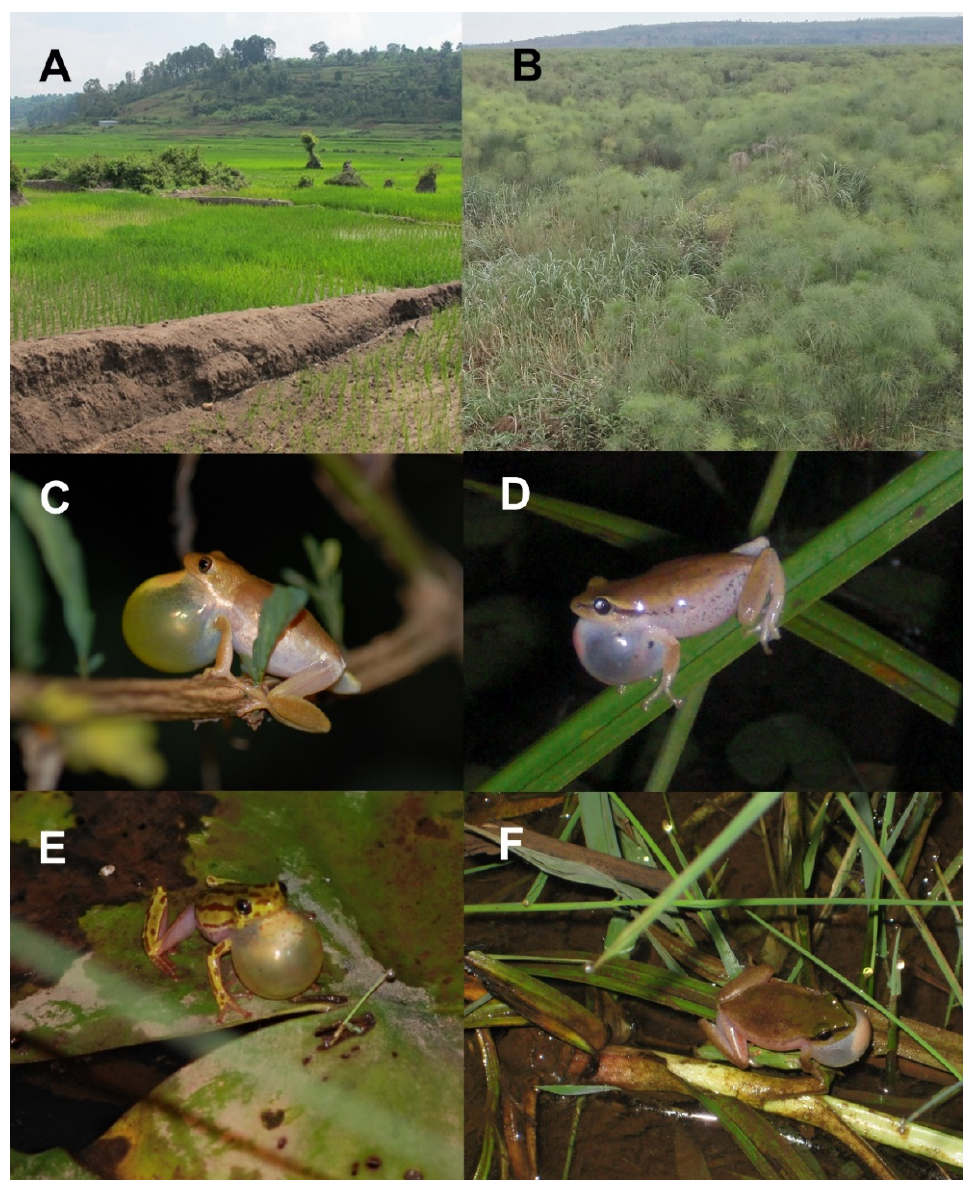
Figure 1. Macro- and microhabitats of the host frogs H. kivuensis and H. viridiflavus . ( A ) Flooded rice field with irrigation channels in Huye (HK and HV in syntopy); ( B ) dense papyrus swamp in Mugesera (only HK); ( C,D ) calling sites 40–60 cm above ground; ( E,F ) calling sites close to the water surface on floating leaves. Hyperolius kivuensis is shown on ( D , F ), H. viridiflavus on ( C , E ).